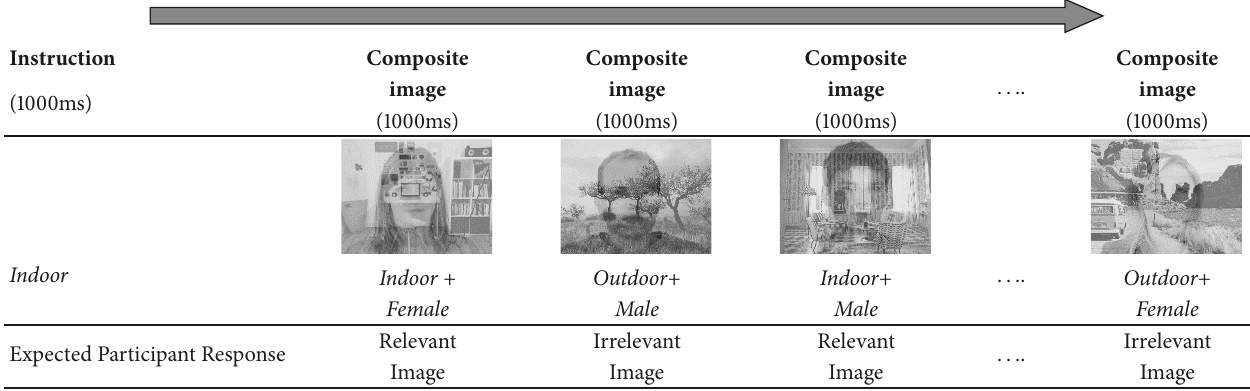
Table 1: A sample sequence of trials. A participant was expected to respond to the task-relevantimages by clicking the mouse while ignoring the task-irrelevant images (from left to the right: trial sequence).